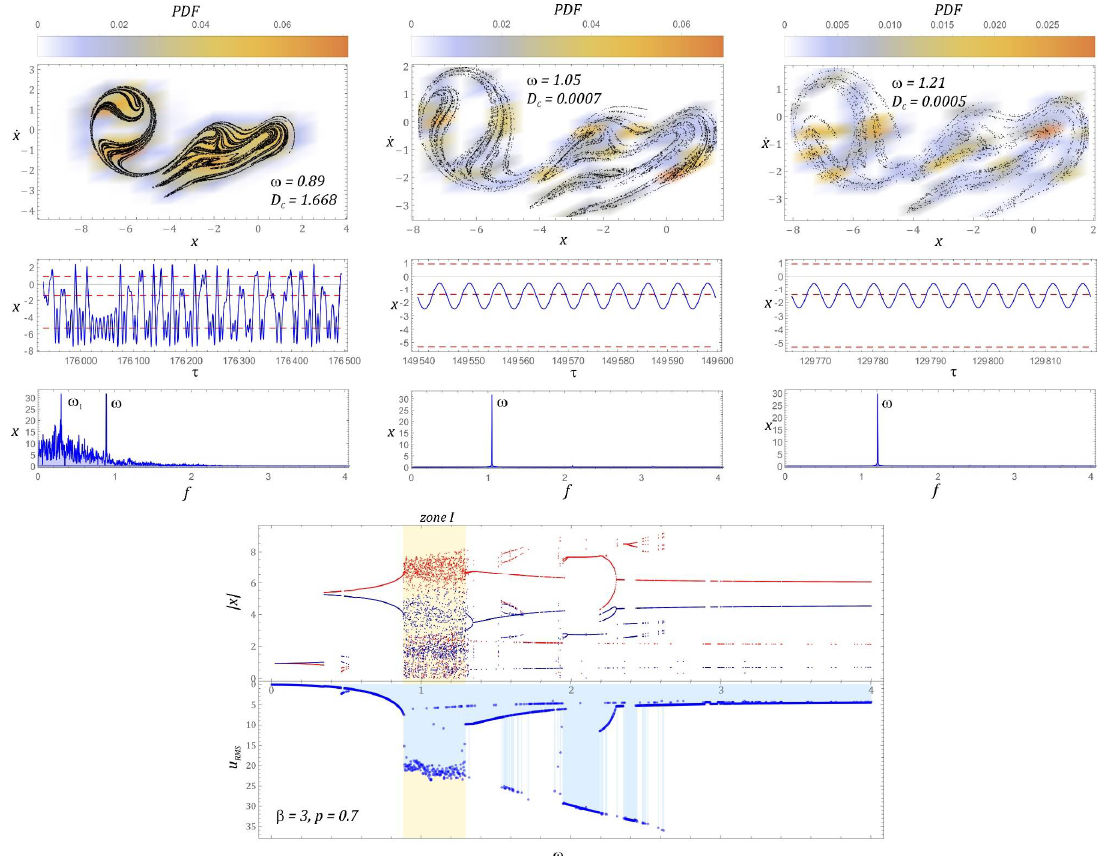
Figure 12. Bifurcation diagram correlated by the frequency spectra with the diagram of RMS voltage output induced on piezoelectric electrodes and examples of chaotic responses (Poincaré maps with correlation dimension and probability density function (PDF) indicated).